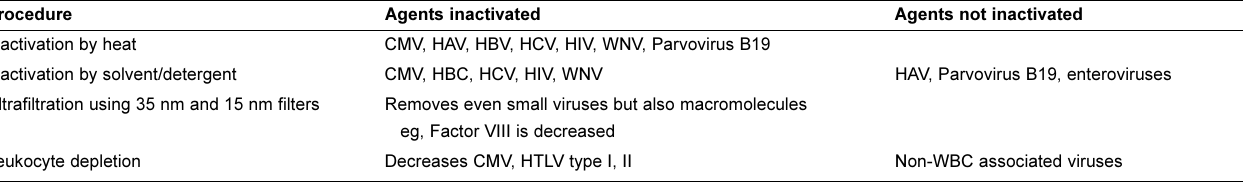
TABLE 2 Specific manufacturing procedures for virus inactivation or removal Procedure